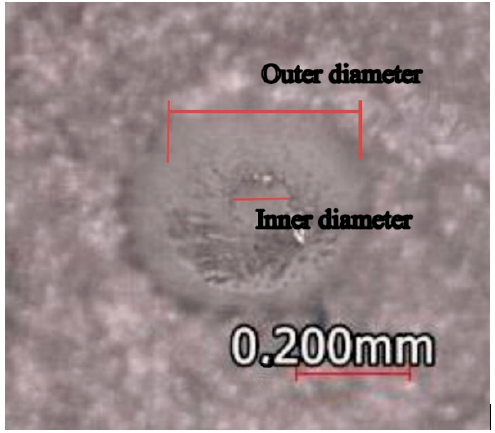
Figure 10. Microneedle internal diameter drilling—Top view.